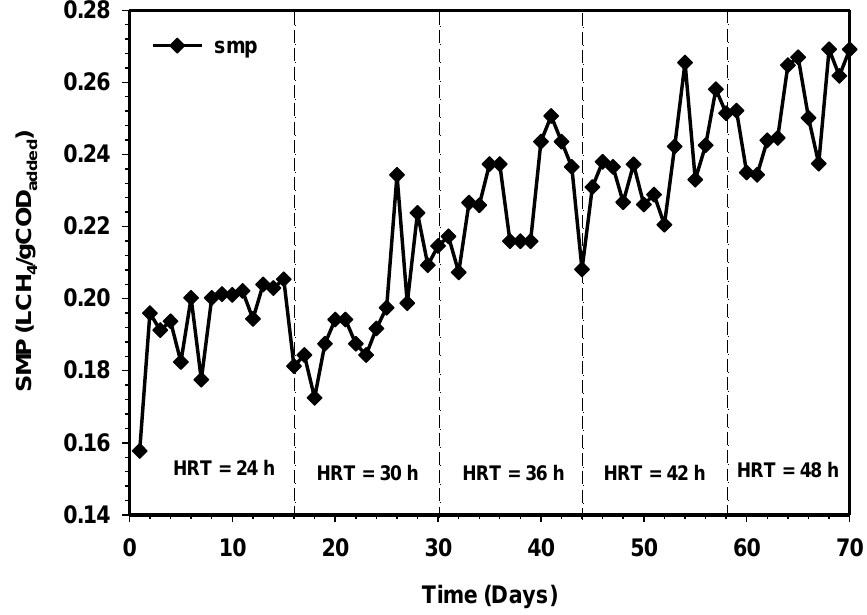
Figure 4. Variation of specific methane production relative to increasing contact time.